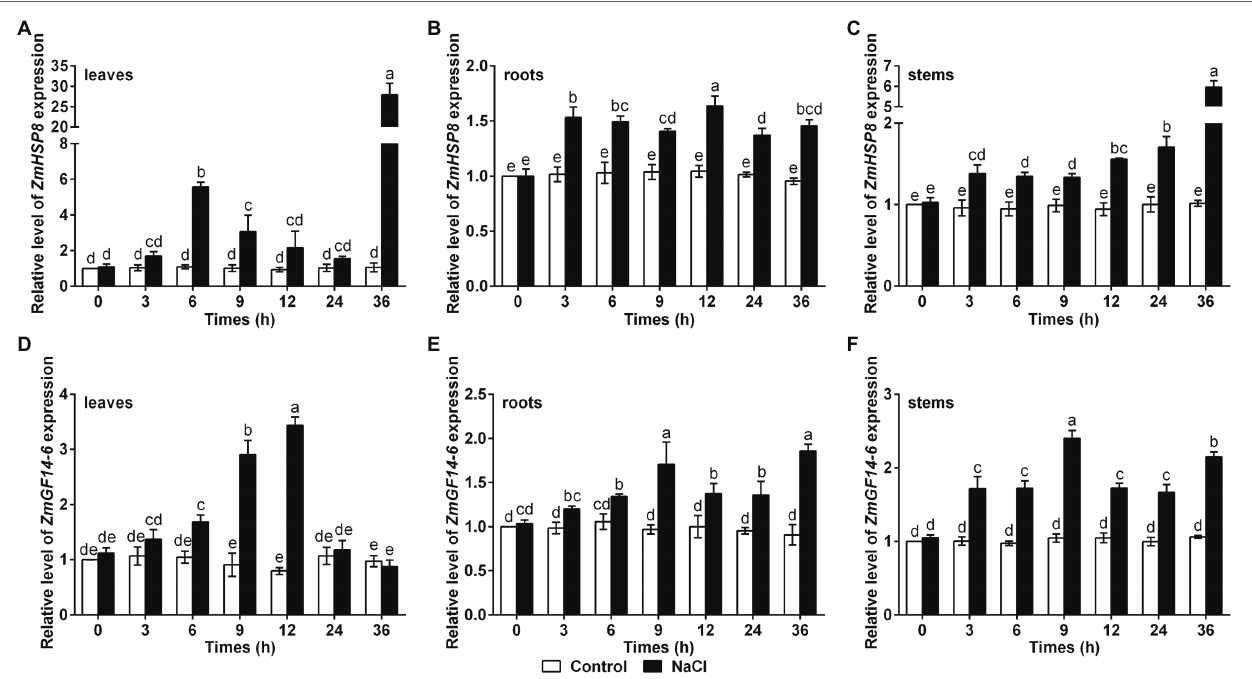
FIGURE 7 | Gene expression patterns of ZmHSP8 and ZmGF14-6 under salt stress. (A–C) The expression levels of ZmHSP8 in maize leaves (A) , roots (B) , and stems (C) exposed to salt stress. (D–F) The expression levels of ZmGF14-6 in maize leaves (D) , roots (E) , and stems (F) exposed to salt stress. About 10-day-old wild type seedlings were treated with 200 mM NaCl for indicated times, and the expression was measured by qRT-PCR. ZmActin2 served as an internal control. Error bars represent ±SD ( n = 3). Different letters indicate significant differences at p < 0.05 according to two-way ANOVA (Duncan’s multiple range